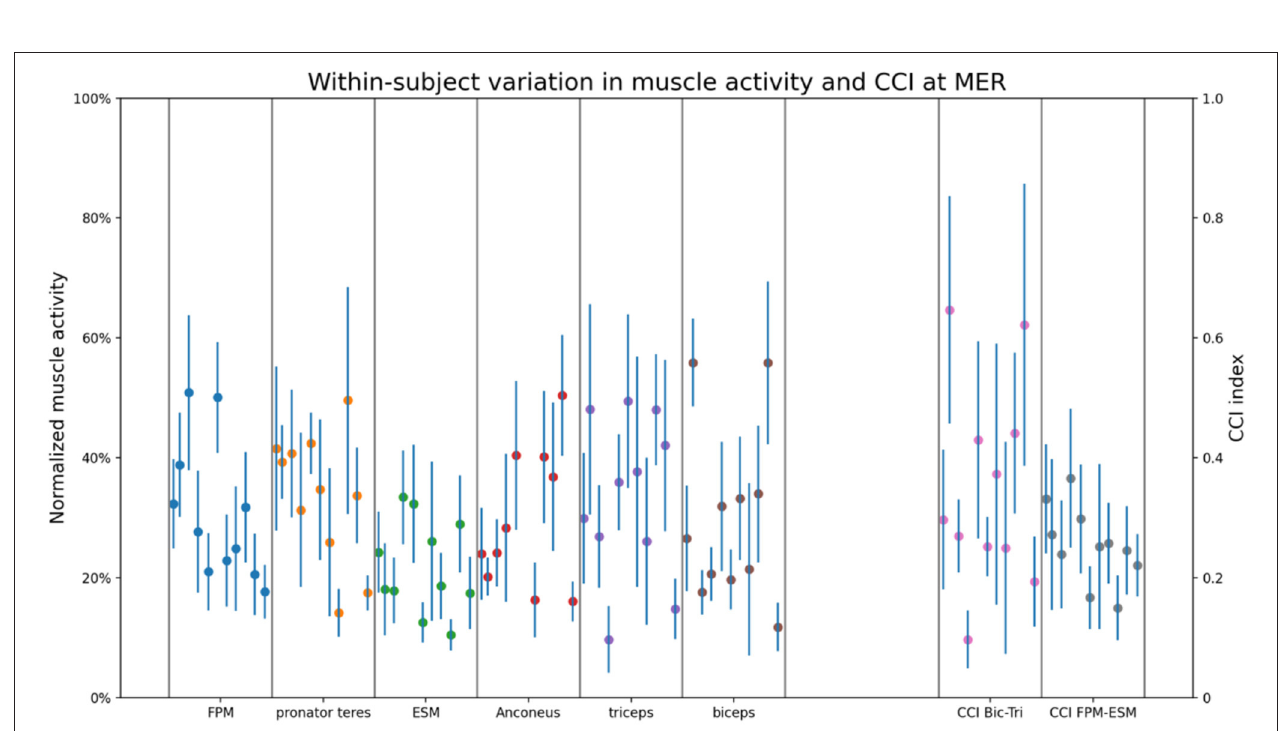
FIGURE 4 | The within-subject variation in muscle activity and CCI for all measured muscles and CCI pairs at MER. Blue vertical lines show the confidence intervals calculated over the 15 thrown pitches. Each blue vertical line within one box (divided by the gray lines), represents the within-subject variation of each individual participant. The dots represent the mean muscle activity of the 15 thrown pitches for each participant.